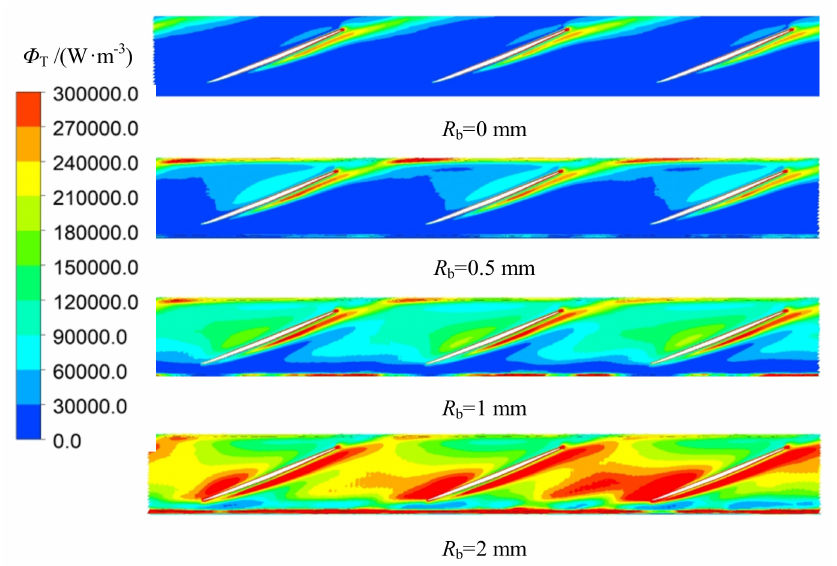
Figure 12. Distribution of total dissipation rate in cylindrical section of impeller under different R b at 1.0 Q des ( Span =